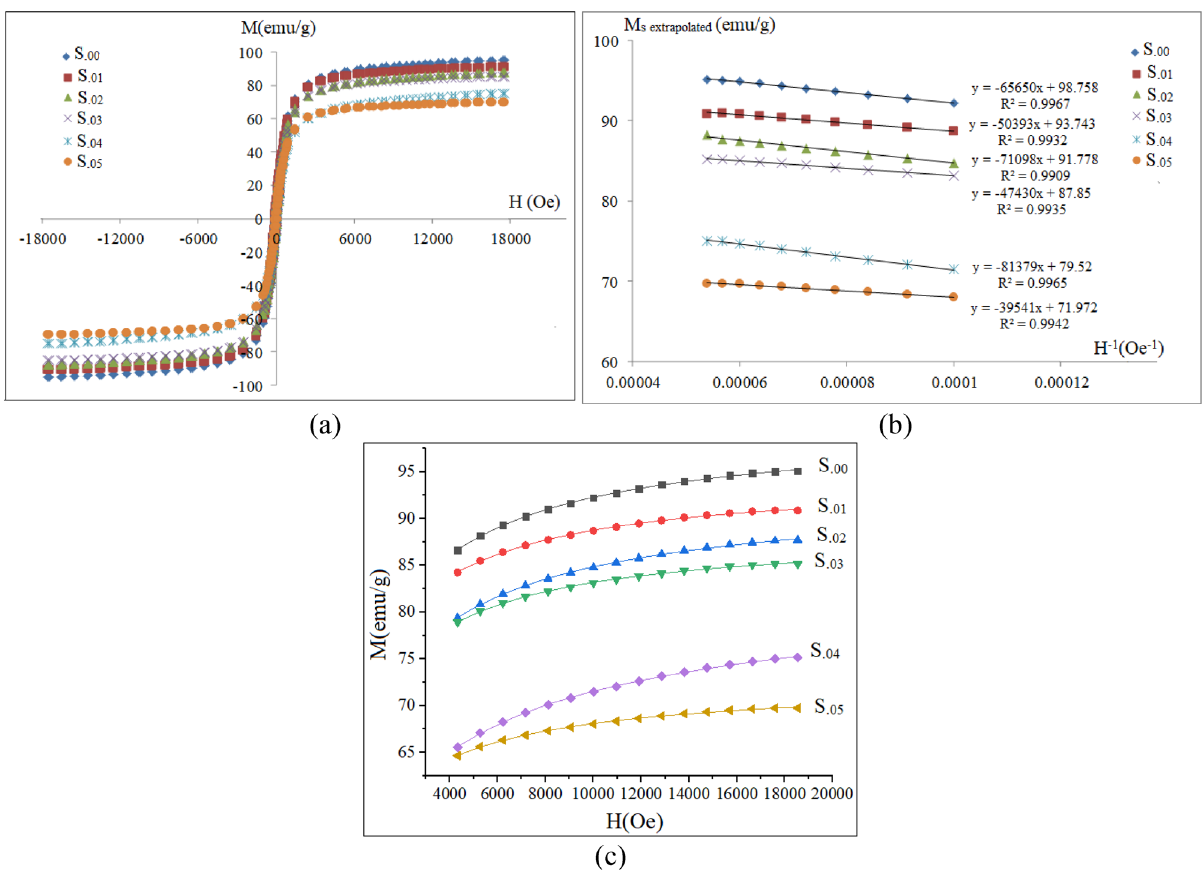
Figure 8. ( a ) Room temperature M-H curves of the as-prepared samples, before coating, ( b ) variation of M versus 1/H (for high field parts H > 10kOe) and linear fittings, and ( c ) fitting of the high field parts of the M-H curves, utilizing the law of approach to saturation.